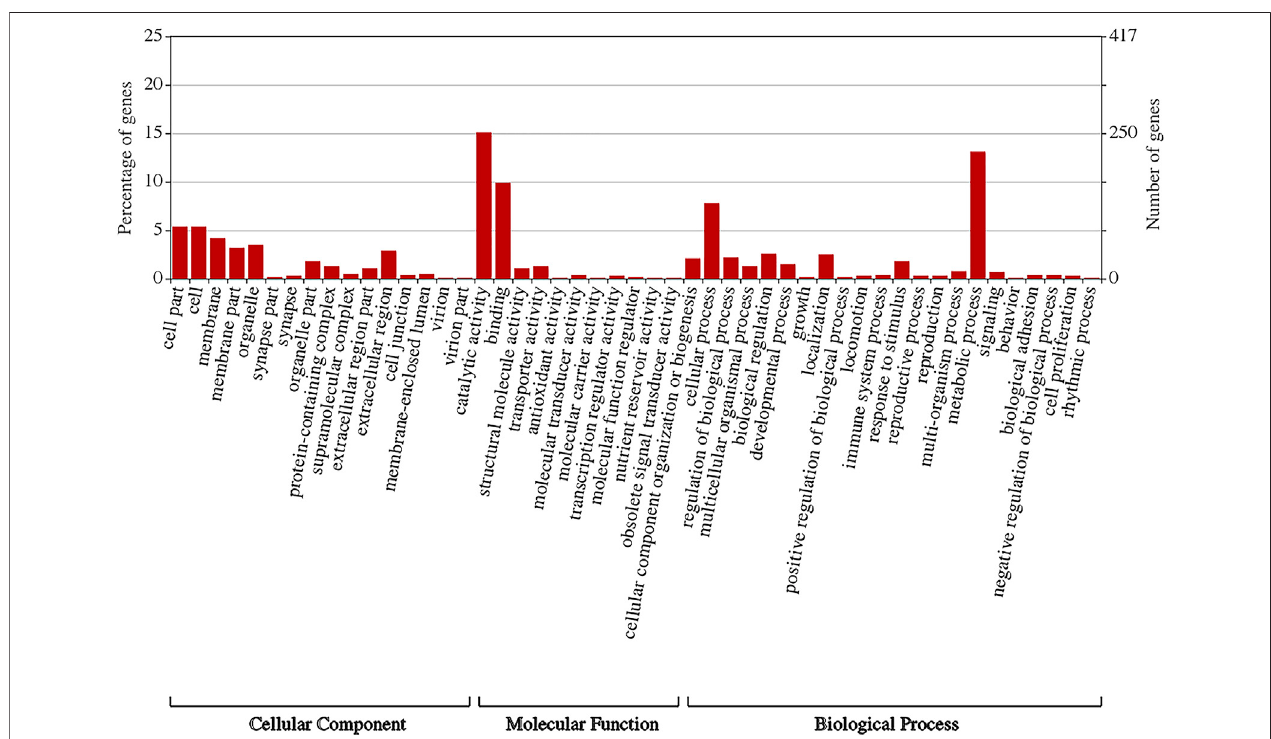
FIGURE 3 | Gene Ontology (GO) classi fi cation of differentially expressed genes (DEGs). Gene Ontology (GO) enrichment analysis of DEGs. Top three enriched terms in cellular component (CC) category were cell ” , “ cell part ” , and “ membrane ” . Terms “ catalytic activity ” , “ binding ” , and “ transporter activity ” were dominant in molecular function (MF) category. In biological process (BP) category, major GO terms were “ metabolic process ” and “ cellular process ” .